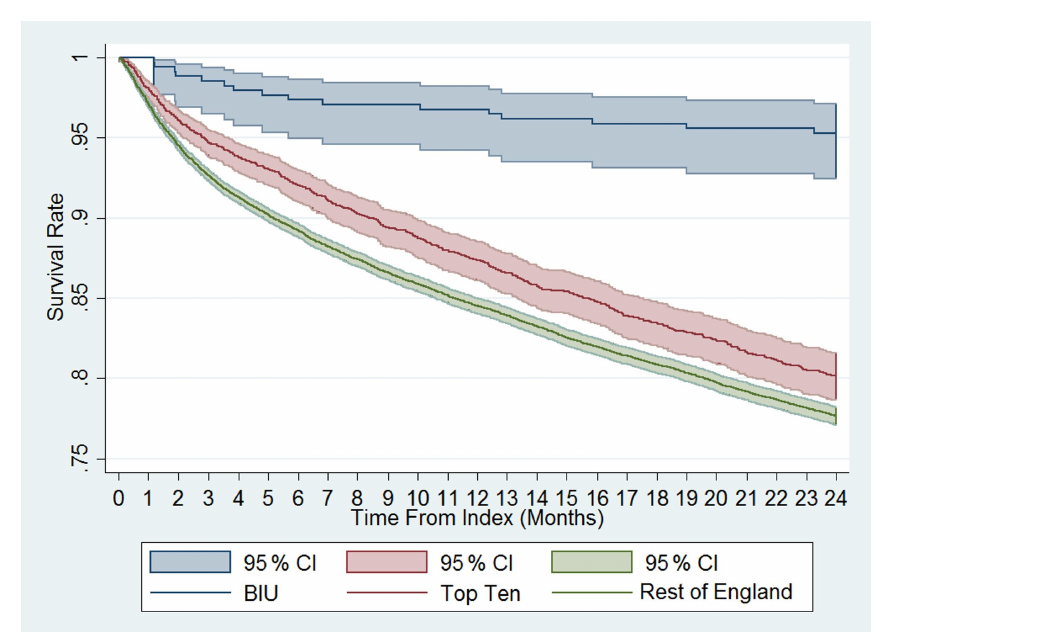
Figure 4. Overall survival following index osteomyelitis surgery; a comparison between the BIU, the Top Ten and the rest of England.